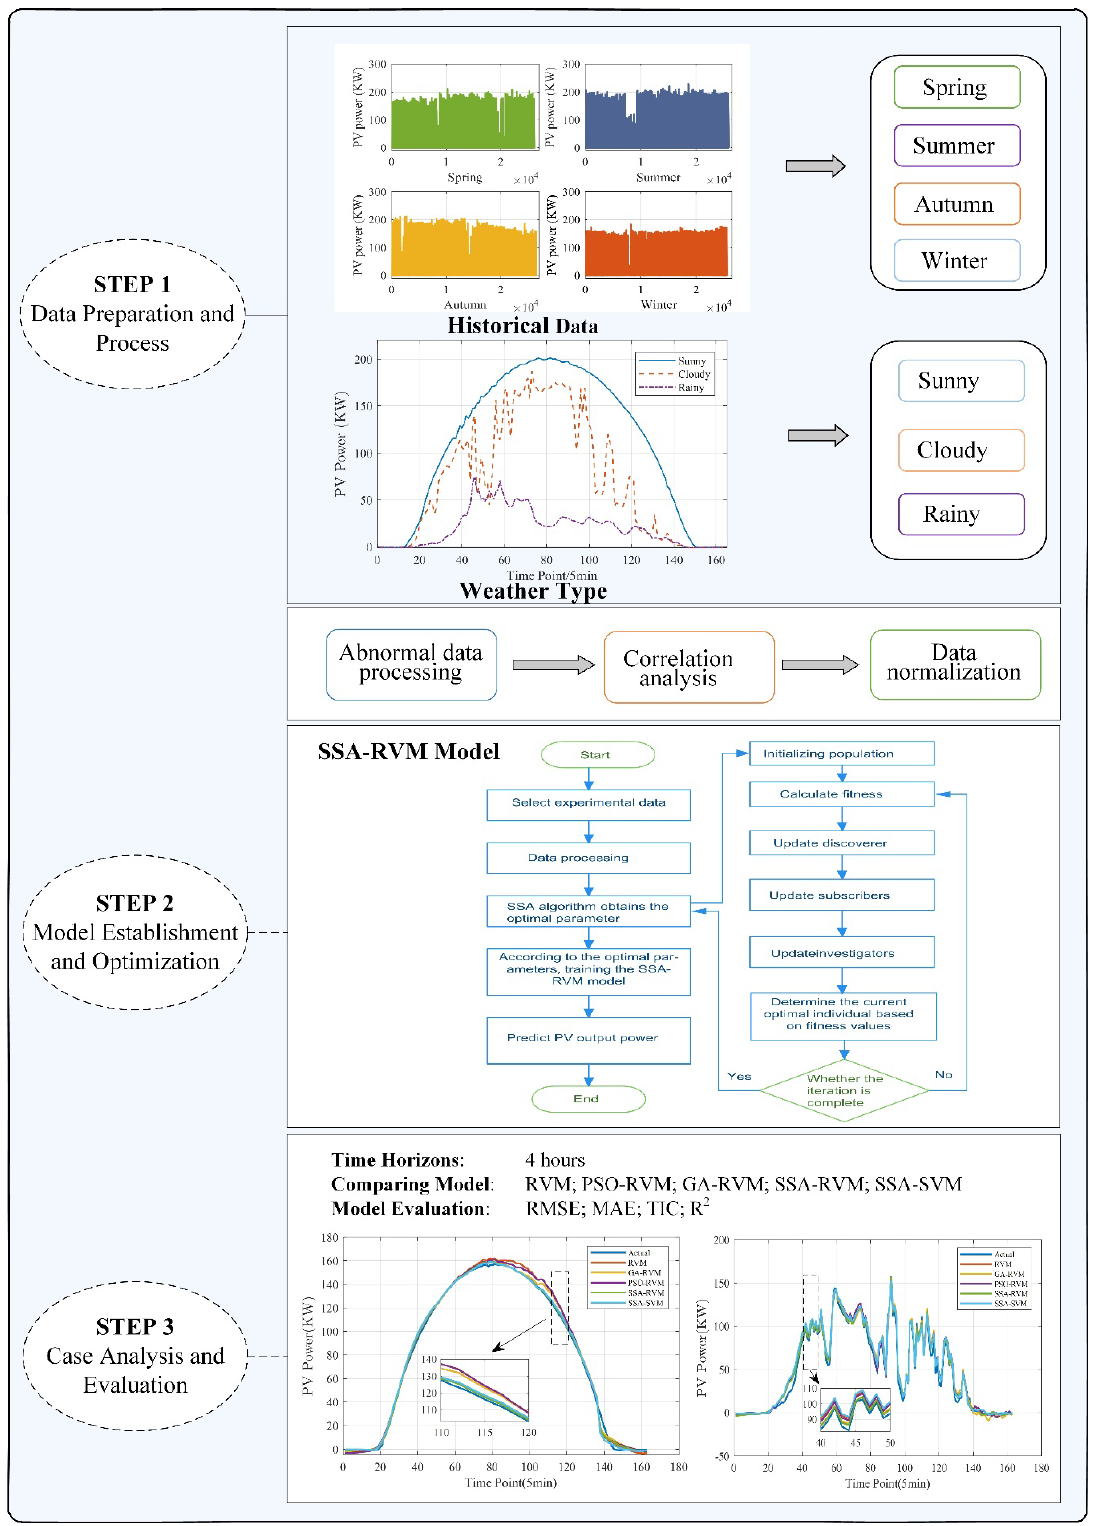
Figure 5. Flow chart of the forecasting model.